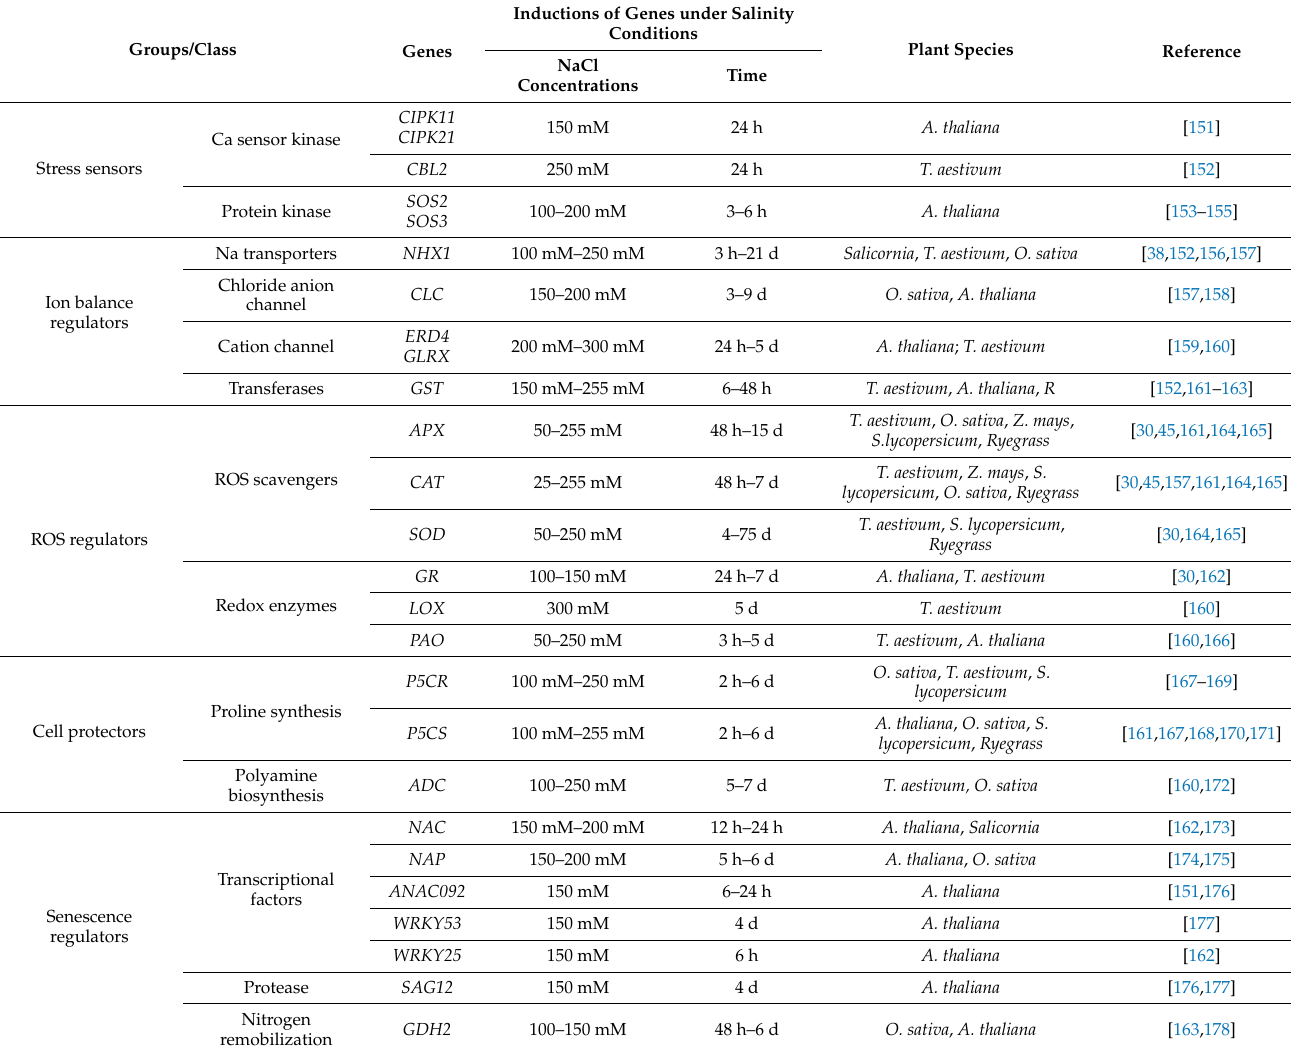
Table 2. List of genes, which change their expression under salinity treatments depending on the salt concentration and time of